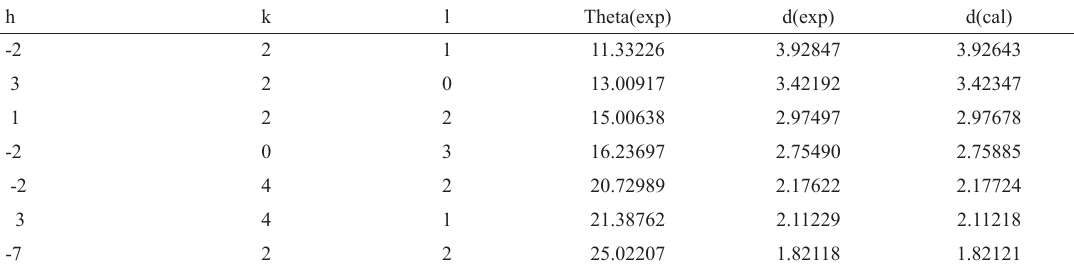
Table 1.2: Parameters evaluated from XRD data of nanocomposite of PPY with nanophotoadduct of potassium hexacyanoferrate(III) with